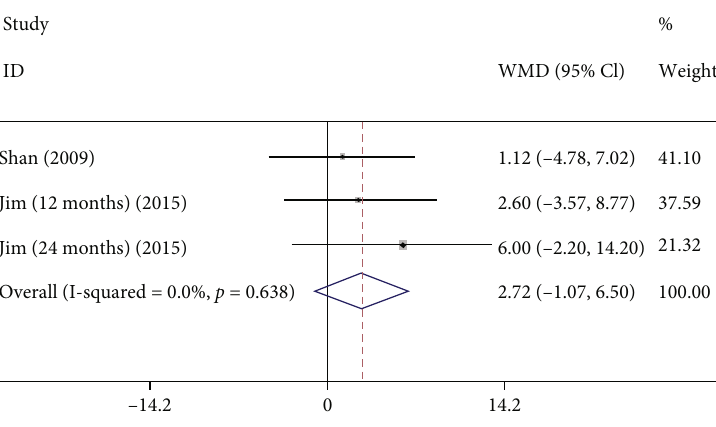
Figure 7: The forest plots of PDI between CMV group and control